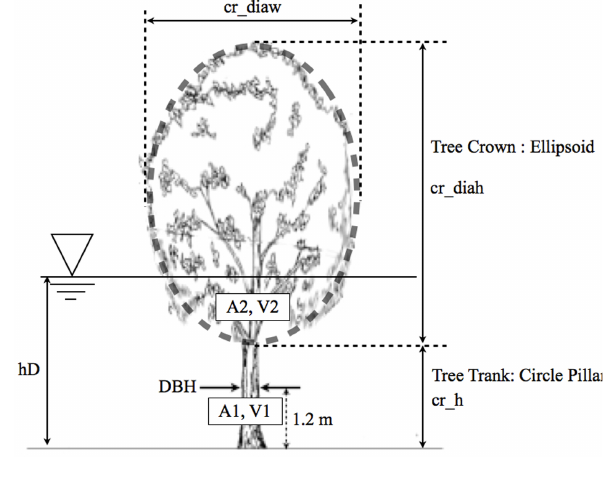
Fig. 1. Input factors of tree